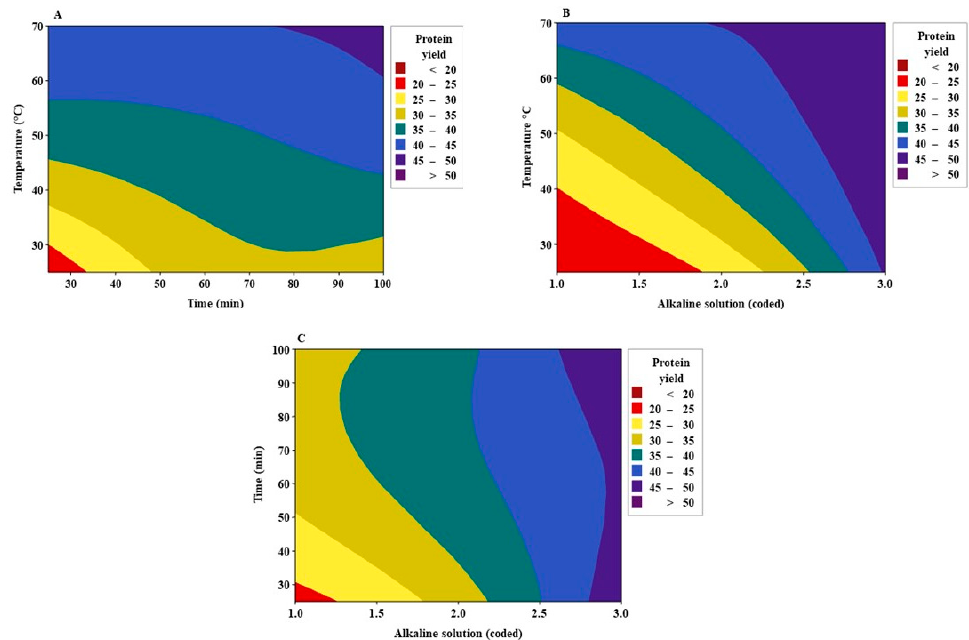
Figure 3. Contour plots of the interactions of temperature vs. time ( A ), temperature vs. alkaline solution ( B ), and time vs. alkaline solution ( C ).